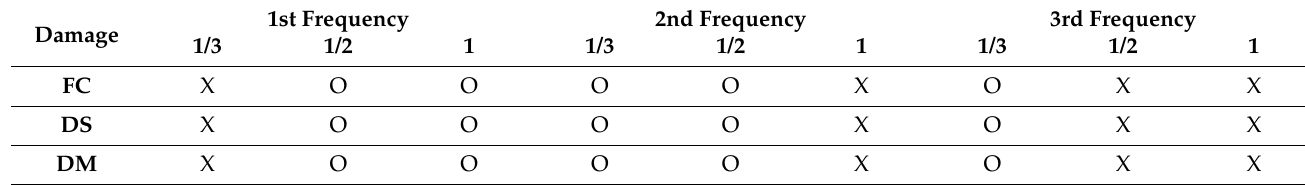
Table 5. Summary for accelerometer (X: not sensitive (0 or 1 sub- or super-harmonic); O: sensitive (2 sub- or super-harmonics); OO: very sensitive (>2 sub- or